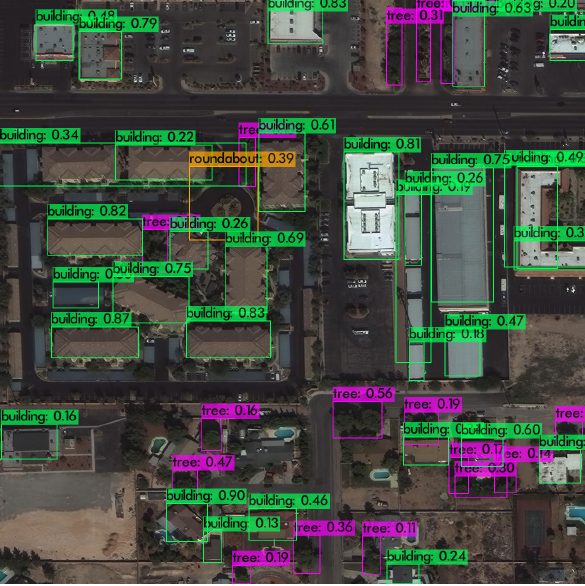
Figure 9. Average precision of various objects using YOLO v4.